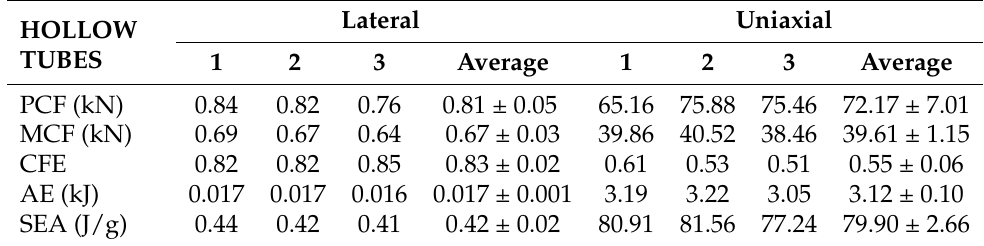
Table 6. Properties of the hollow composite tube under lateral and uniaxial